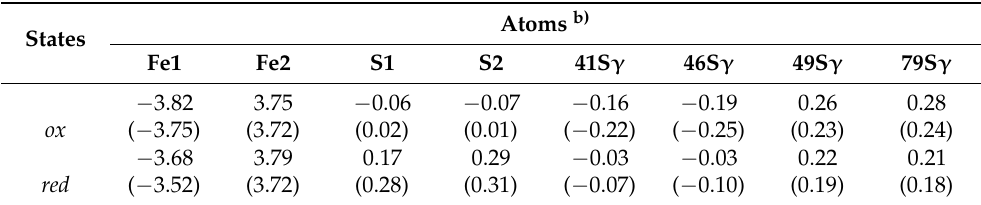
Table 2. Calculated atomic spin densities of oxidized ( ox ) and reduced ( red ) states of 1 H and 1 N a) . States